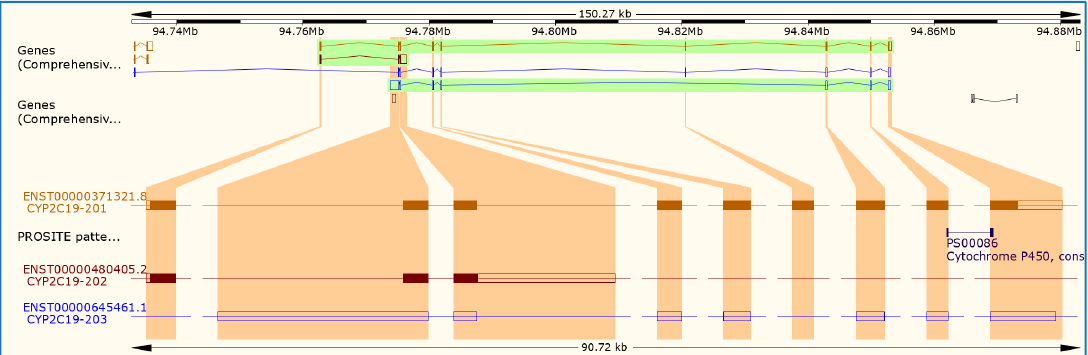
Figure 3. Promoter regions of CYP2C19 transcripts in the human genome. As shown, there are three transcripts for CYP2C19 including CYP2C19-201 (ENST00000371321.3) composed of 1901 nucleotides and protein coding 490 amino acids (aa), CYP2C19-002 (ENST00000464755.1), composed of 2395 nucleotides and no protein coding, and CYP2C19-003 (ENST00000480405.1) composed of 1417 and no protein coding.